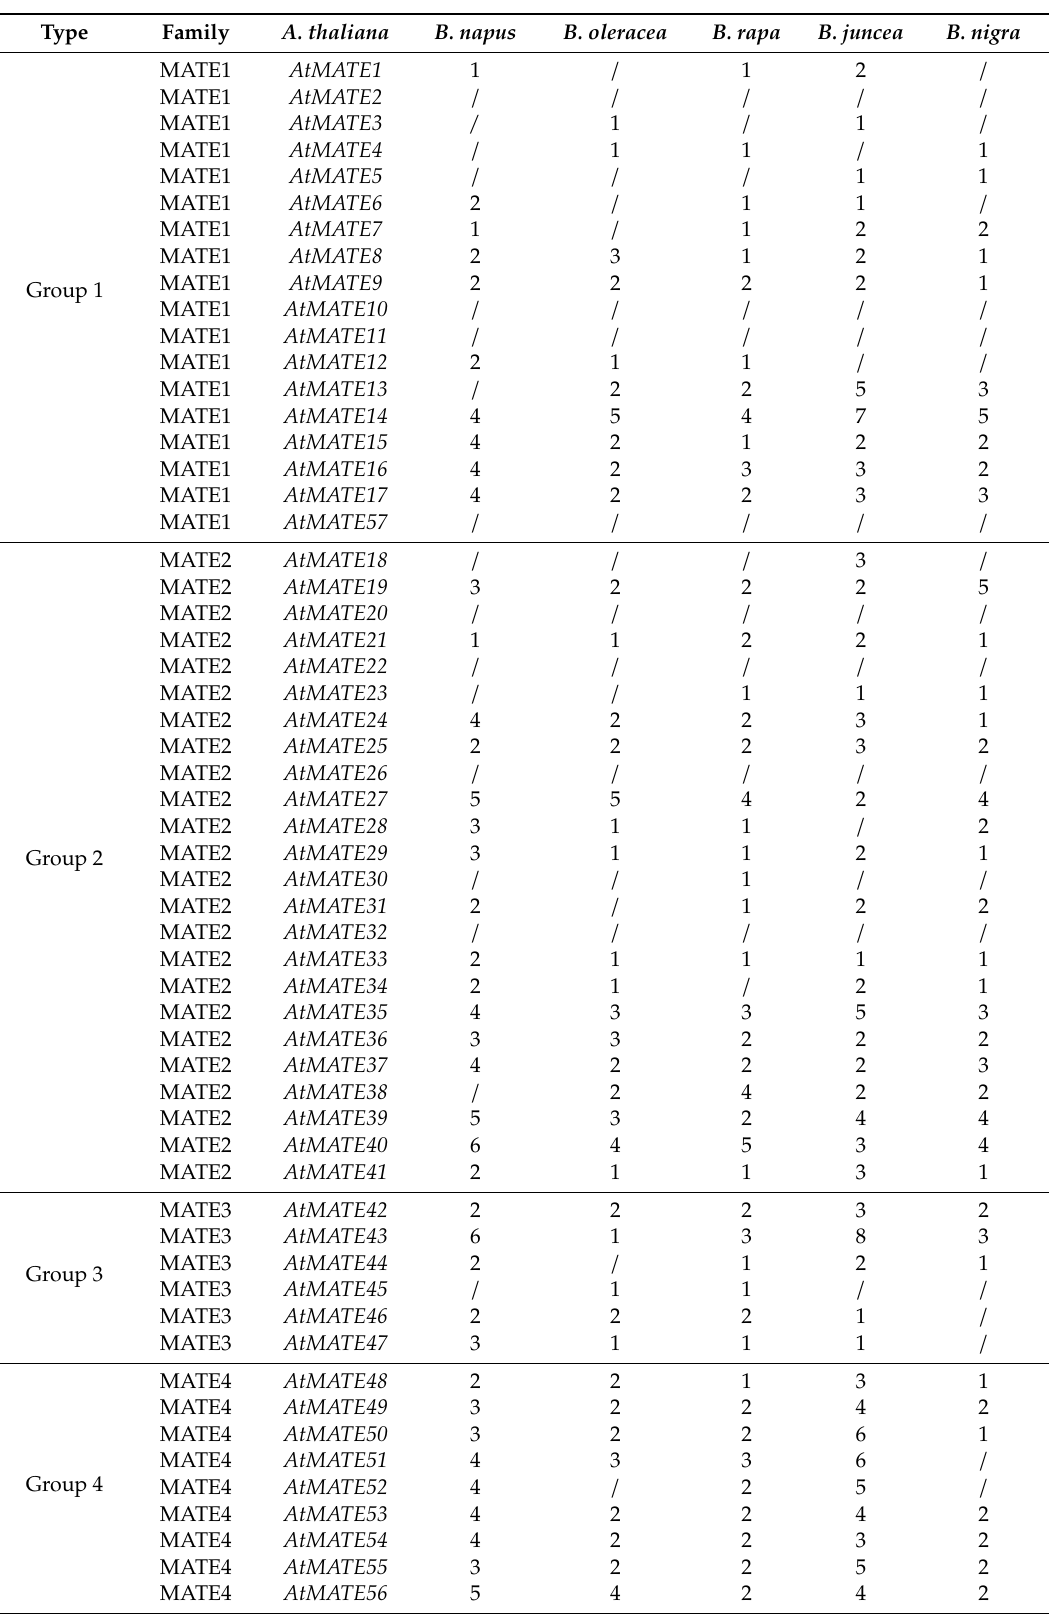
Table 1. Statistics for MATE genes in each subgroup between A. thaliana and five Brassicaceae species.